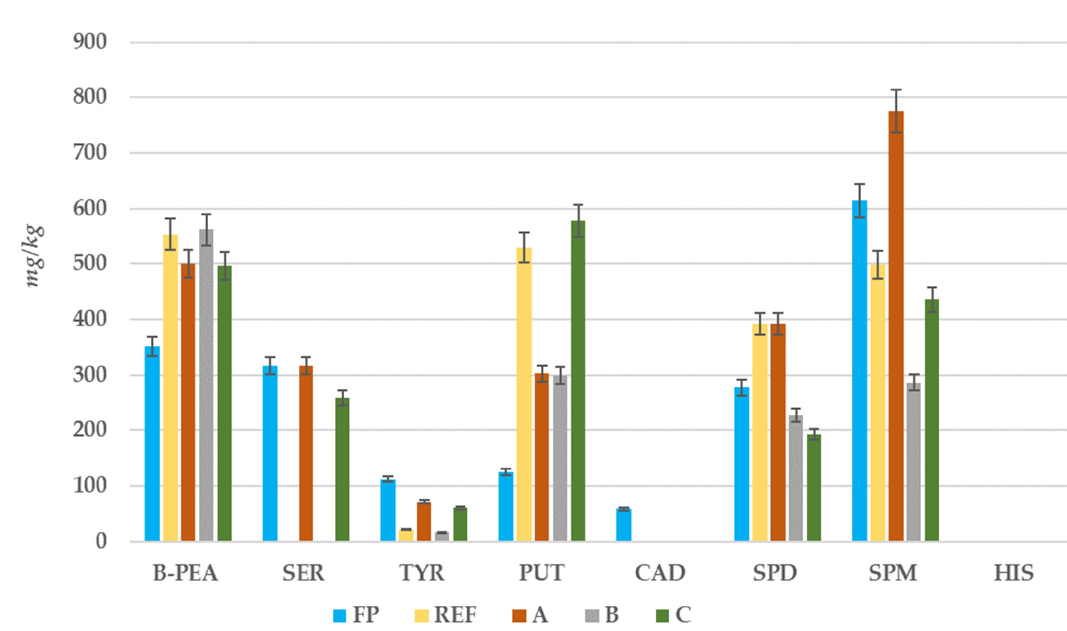
Figure 6. Biogenic amines content in fresh (t 0 ) and packaged pumpkin samples (t 11 ). FP: Fresh pumpkin (light blue trace); REF: polyethylene (yellow trace); A: biodegradable cellophane from regenerated cellulose (orange trace); B: biofilm obtained from maize starch, cassava, eucalyptus (grey trace); C: poly-lactate obtained from maize starch (green trace). β -PEA: β -phenylethylamine; PUT: putrescine; CAD: cadaverine; HIS: histamine; SER: serotonin; TYR: tyramine; SPD: spermidine; SPM: spermine.